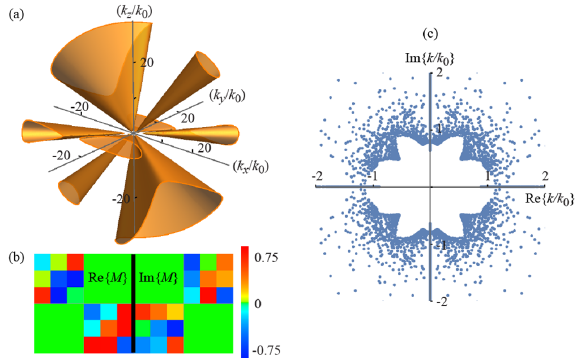
Figure 1. ( a ) Iso-frequency Fresnel wave surface for a tetra-hyperbolic bianisotropic medium with the effective material parameters matrix ˆ M color-coded in ( b ); ( c ) eigenvalues of the index of refraction’s operator [31–33] in a complex plane for the same